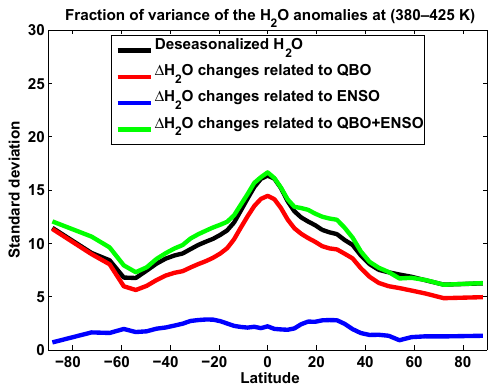
Figure 5. Standard deviation (SD) of the global deseasonalized MLS H 2 O (black) together with the SD of the ENSO (blue), QBO (red) and ENSO plus QBO (green) impact on lower stratospheric H 2 O derived from the multiple regression fit results shown in Fig.